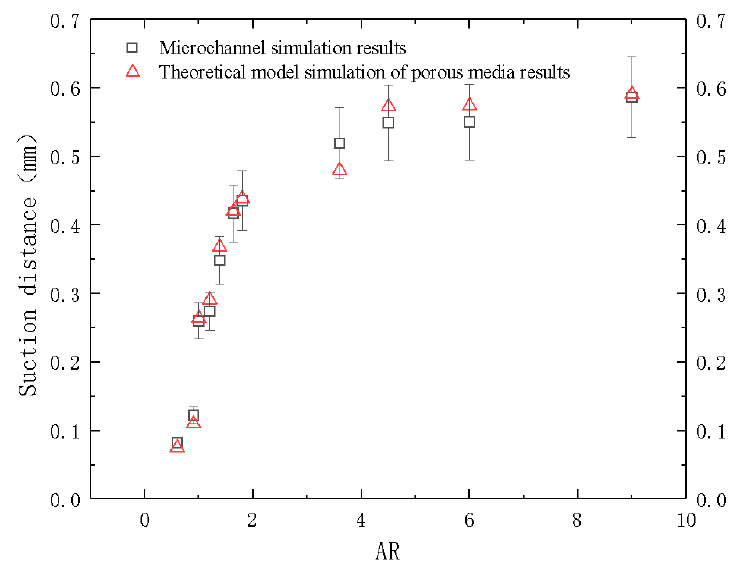
Figure 8. Curves of suction distance depending on AR from microchannel and porous media models.